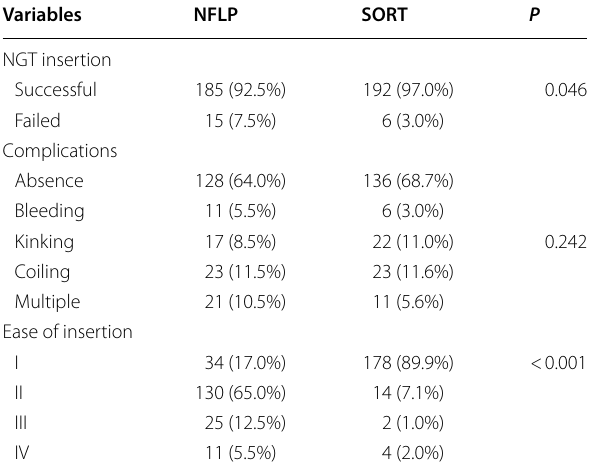
Table 2 Comparing the outcomes of interest between the study groups